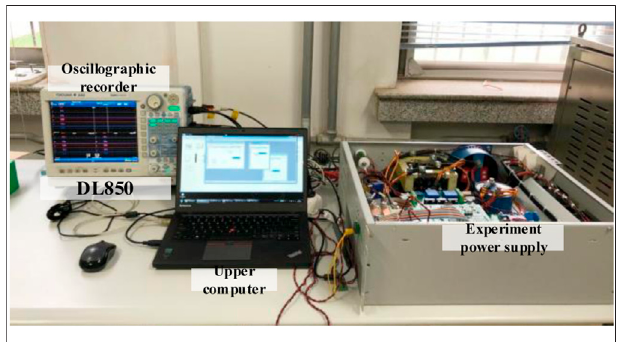
FIGURE 9 | Experimental system